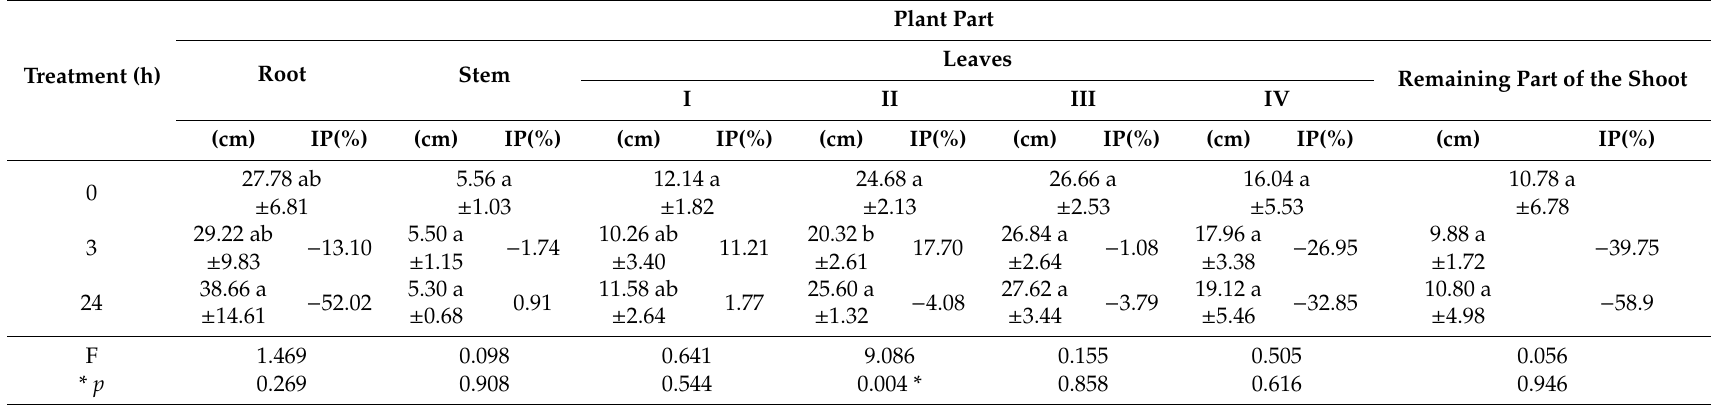
Table 6. Length of triticale ( × Triticosecale Wittm. ex A.Camus) plants grown from grains irradiated with a helium-neon (He-Ne) laser by 3 and 24 h; mean ± SD (n =